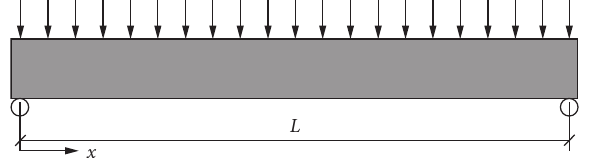
Figure 1: Euler–Bernoulli beam.